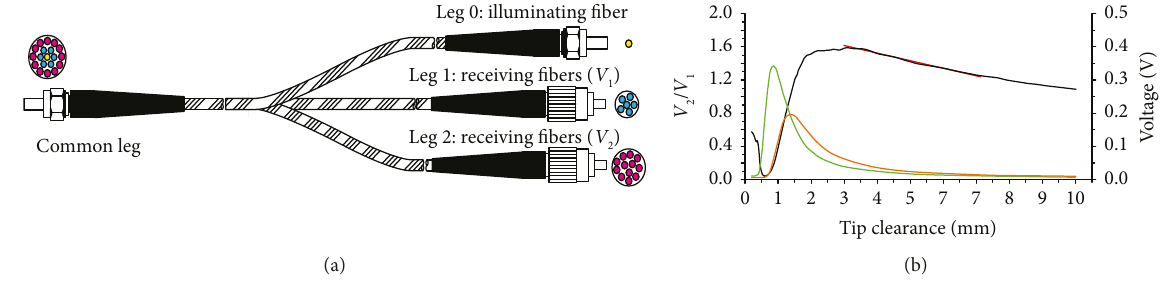
Figure 2: (a) Trifurcated optic sensor diagram. (b) Sensor response (black) over distance ( V